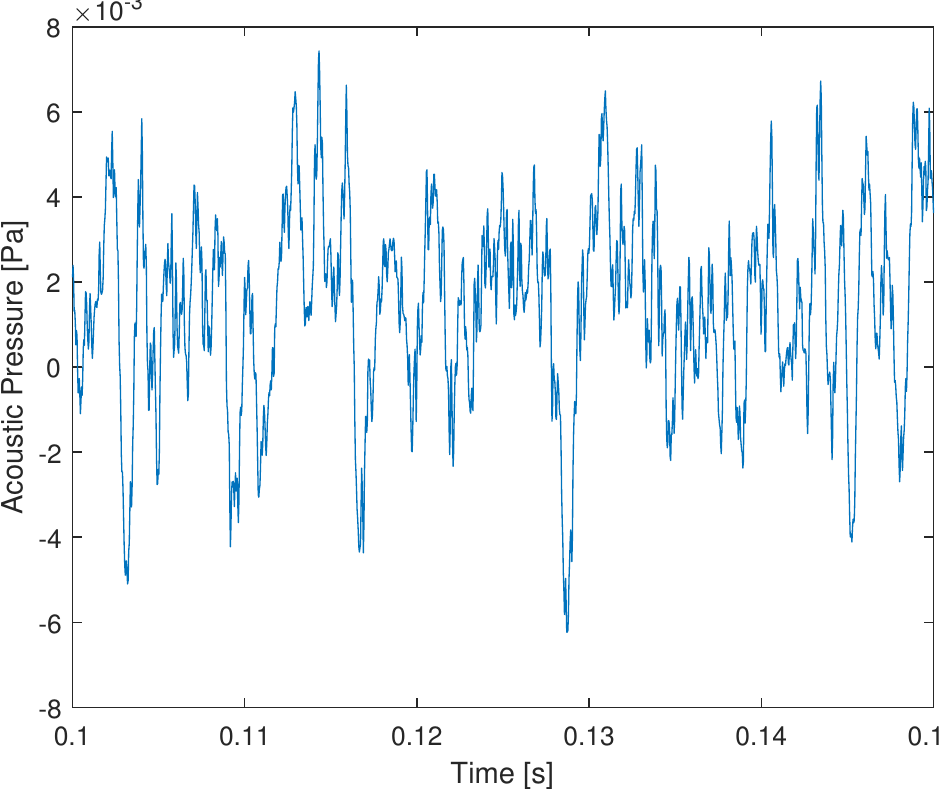
Figure 6. Close–up of computed acoustic pressure of the NACA 0018